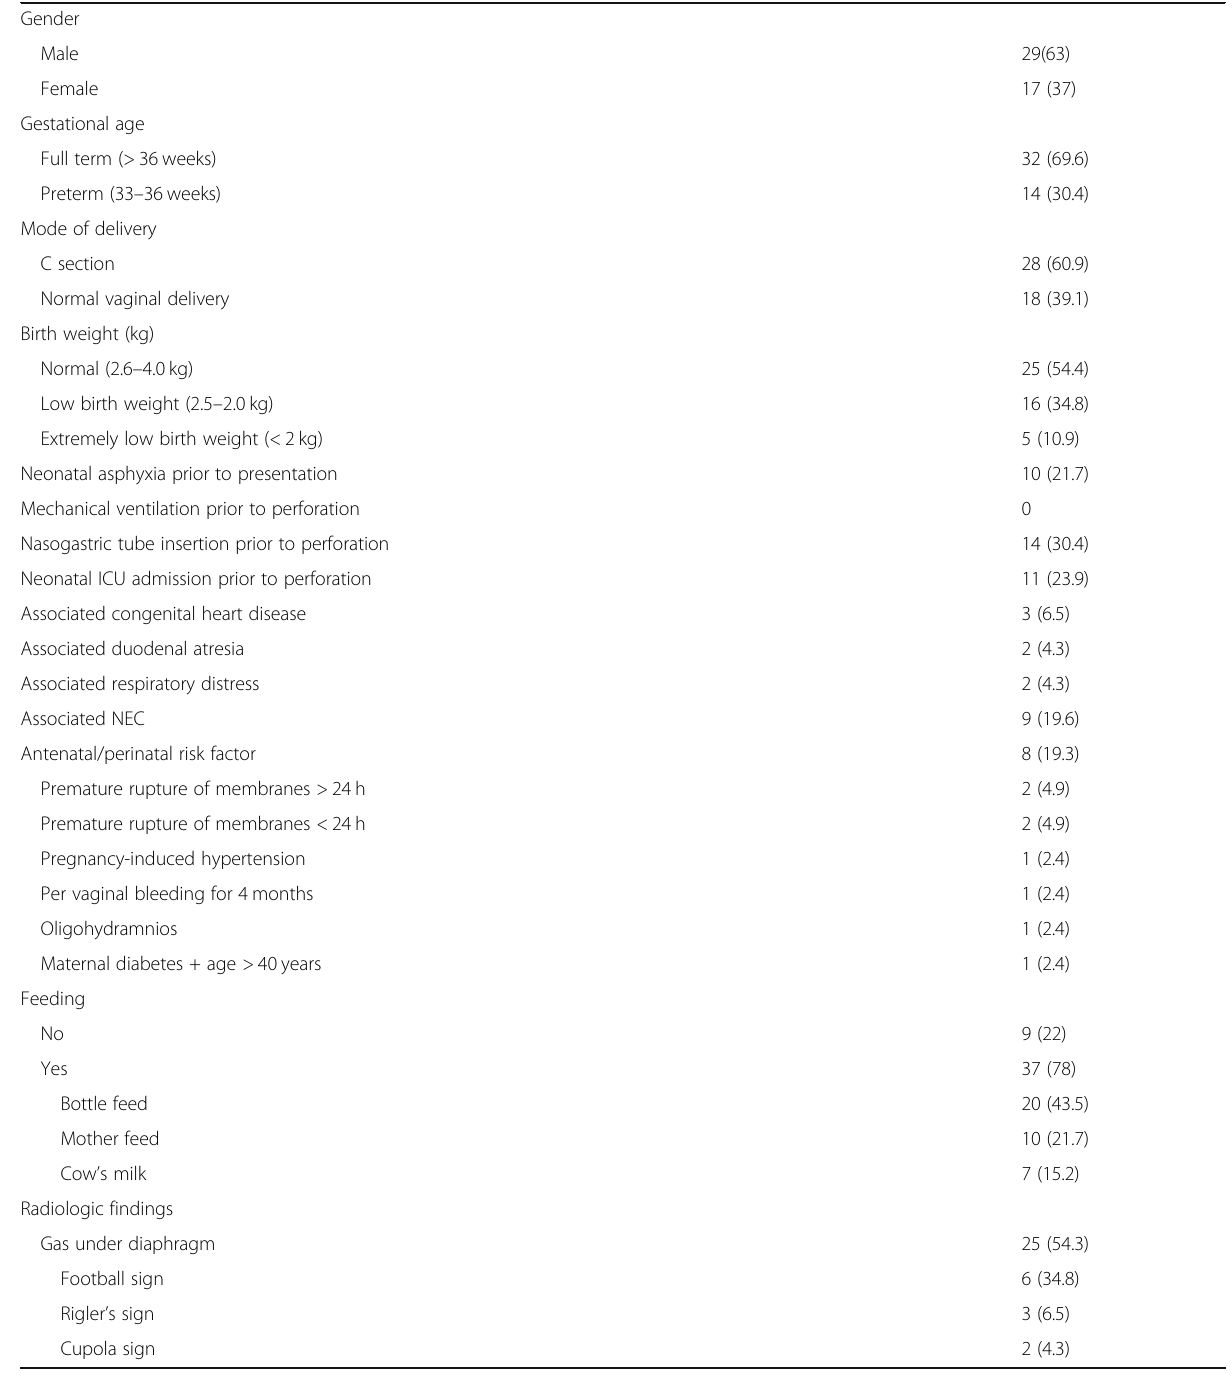
( n =10), and burst abdomen ( n =5). Regarding clinical Table 3.